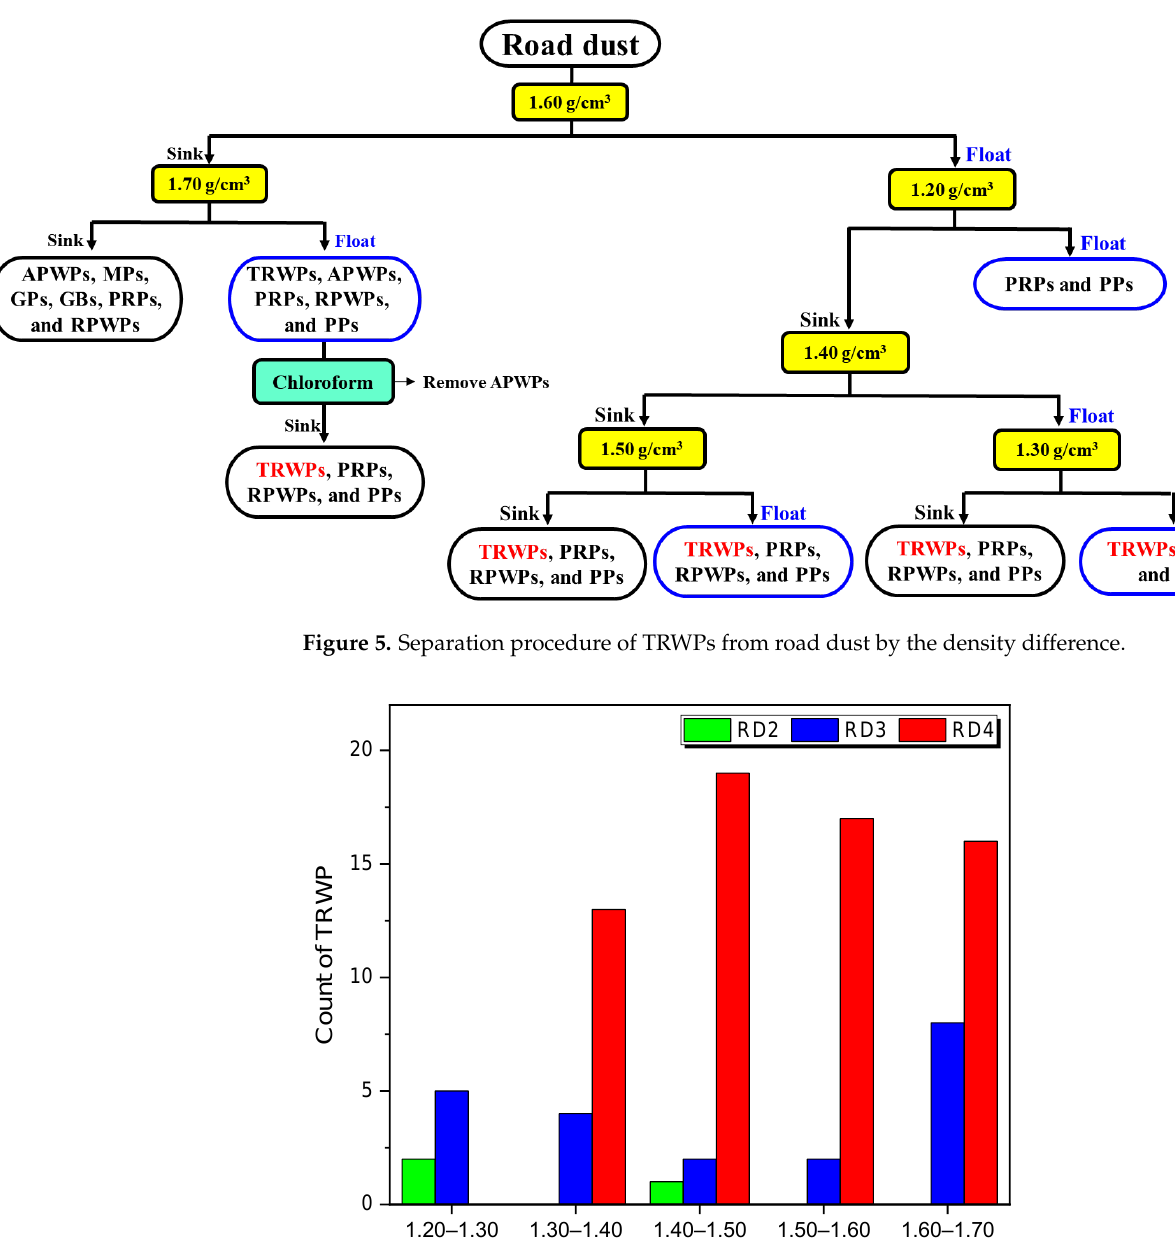
Figure 5. Separation procedure of TRWPs from road dust by the density difference.